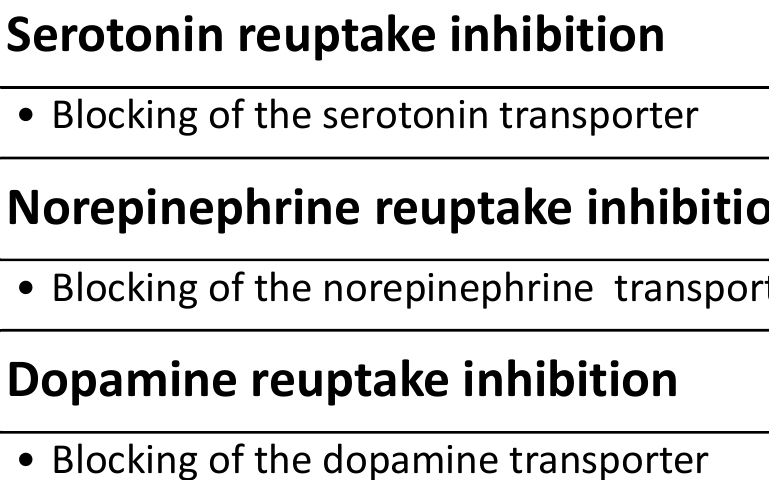
Figure 1. Mechanisms of action for TRI as antidepressants.